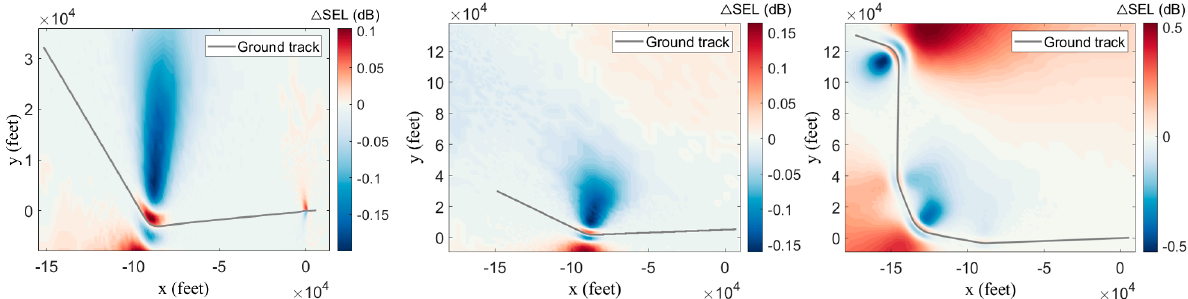
Figure A12. Various aircraft approaching HKIA. Difference in the noise impact (SEL) generated by flights AA3 (left), BA1 (center) and BA2 (right), due to the incorporation of bank angle effect.